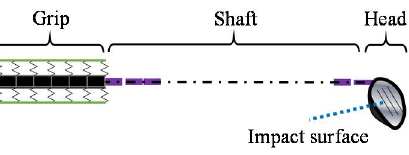
Figure 1. Physical model with multistage beam. The model is divided into three parts: the golfer’s grip part considered as a spring model, shaft, and head.